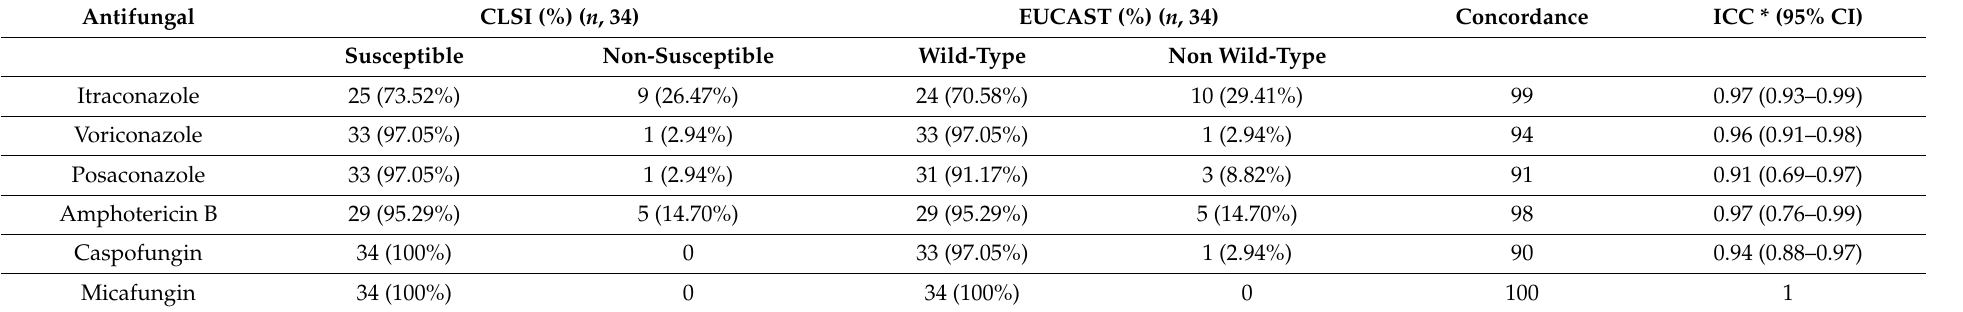
Table 6. Concordance and intraclass coefficients (ICC) between CLSI M38-A2 and EUCAST guidelines.